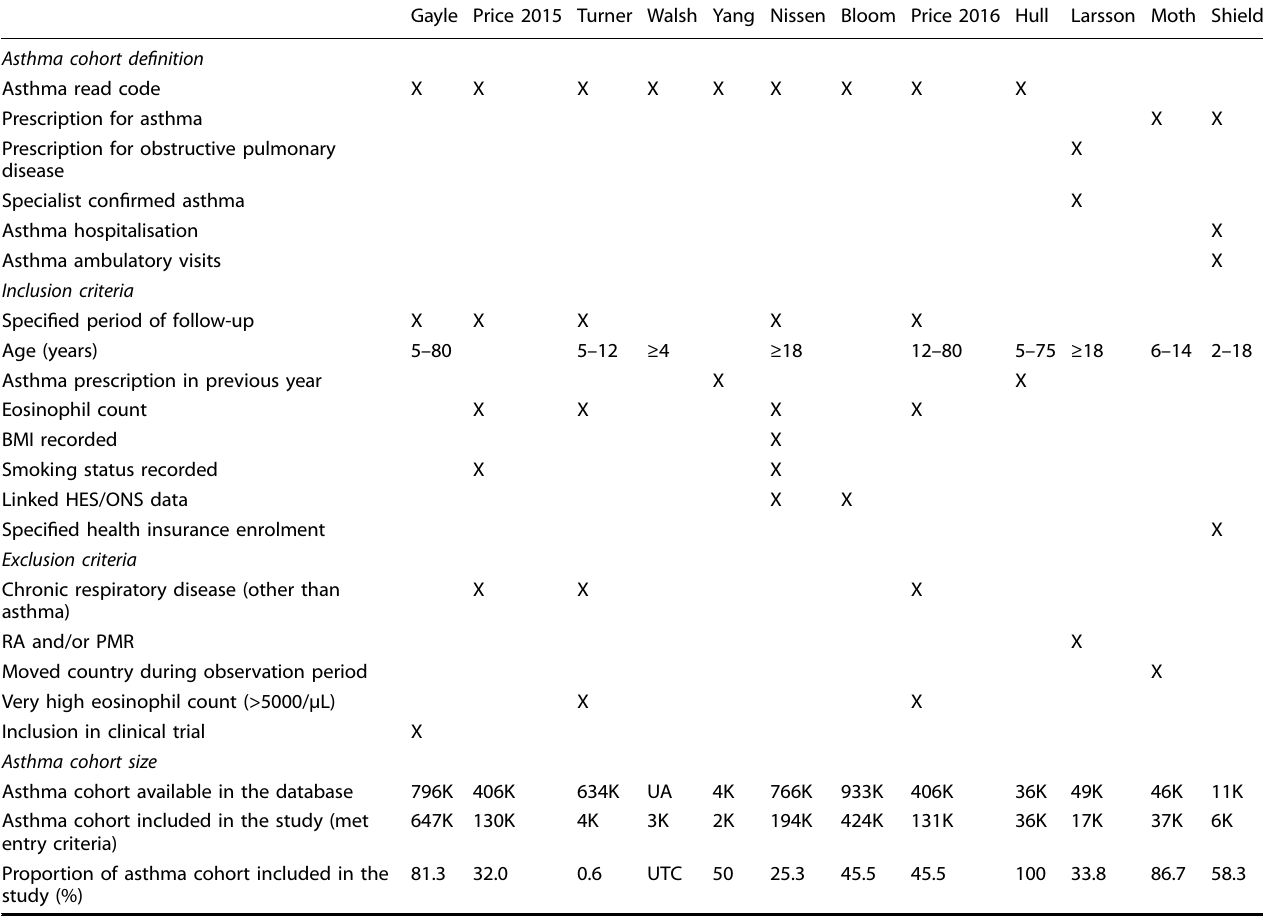
Table 2. De fi nitions, inclusion and exclusion criteria and size of asthma